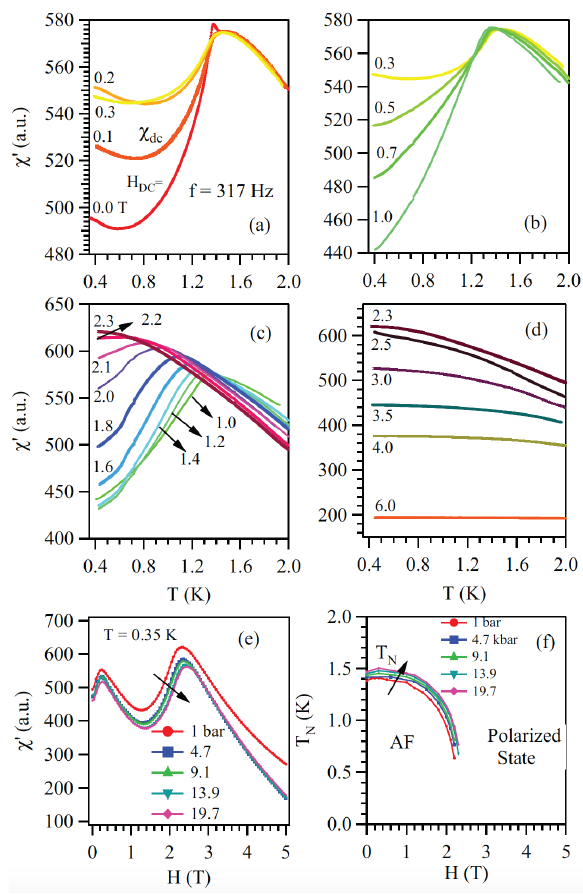
Figure 10. (color online) All data for Er 2 Ge 2 O 7 . ( a – d ) Temperature dependence of the ambient-pressure χ (cid:48) under different dc magnetic fields. ( e ) Field dependence of χ (cid:48) measured at T = 0.35 K under different pressures. ( f ) Field dependence of T N under different pressures. From Ref.